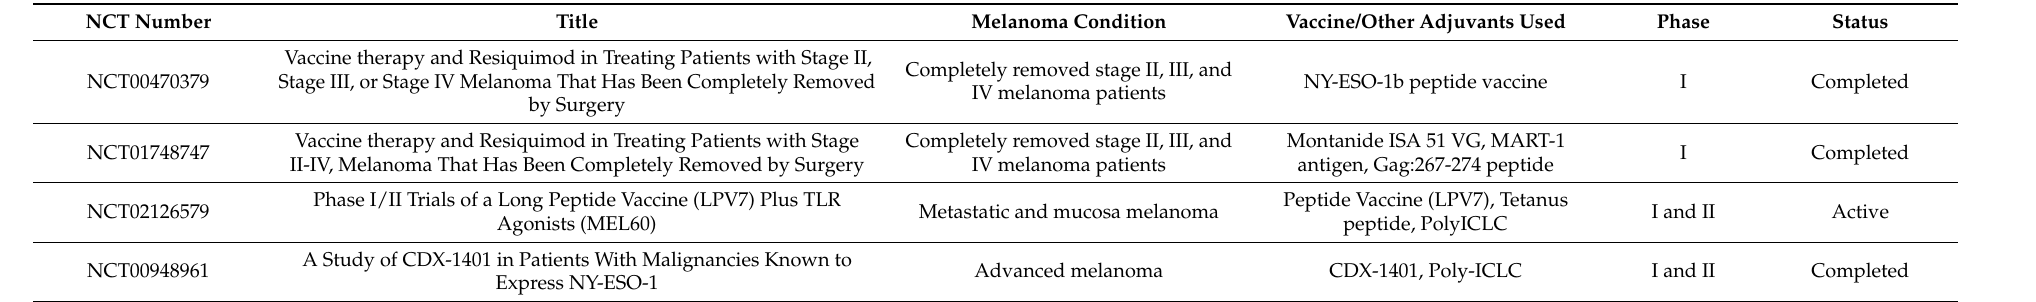
Table 3. Clinical trials involving the use of topical RSQ as an adjuvant for melanoma treatment (data from www.clinicaltrials.gov accessed on 14 September